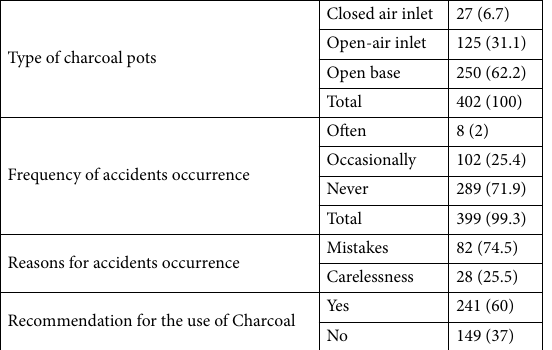
Type of charcoal